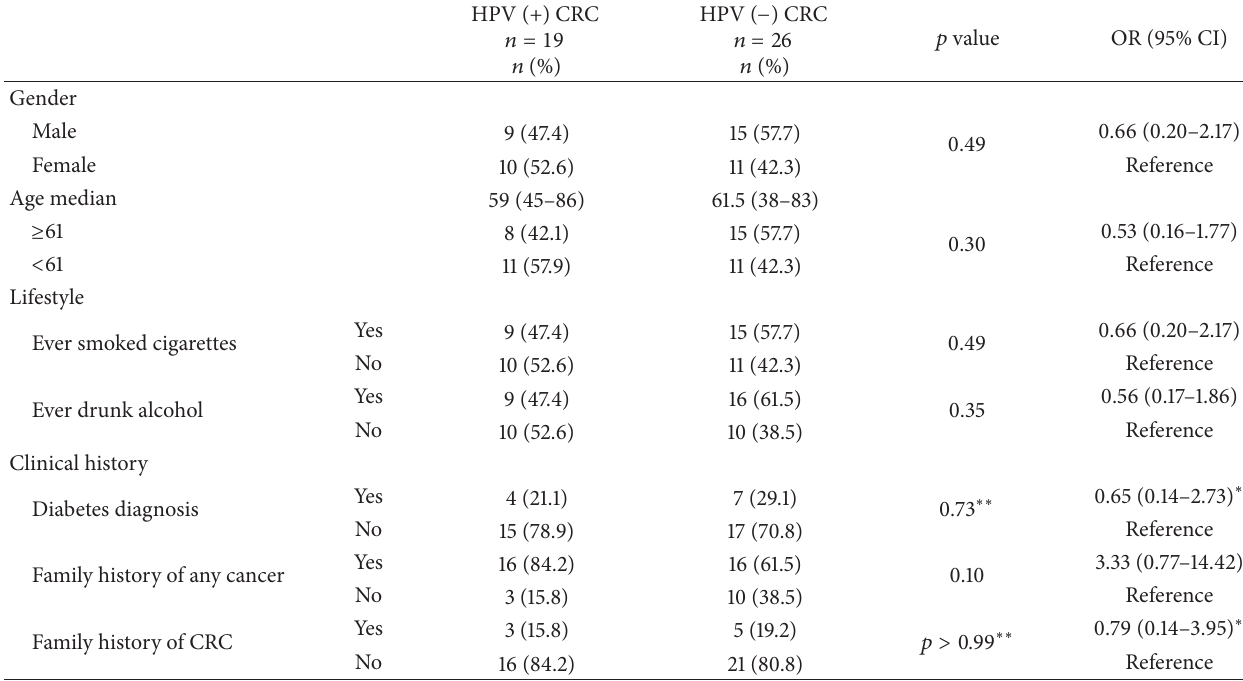
Table 3: Summary of the demographic, lifestyle, and clinical characteristics of the CRC cases according to HPV status.